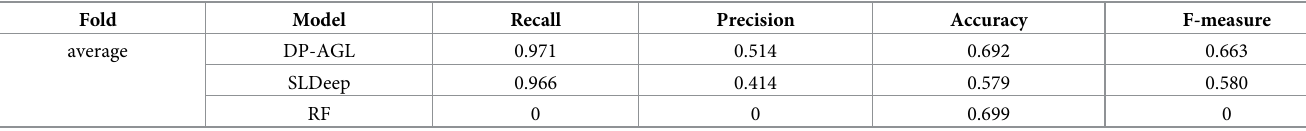
Table 6. Experimental results on testing with accuracy neighborhood 2.